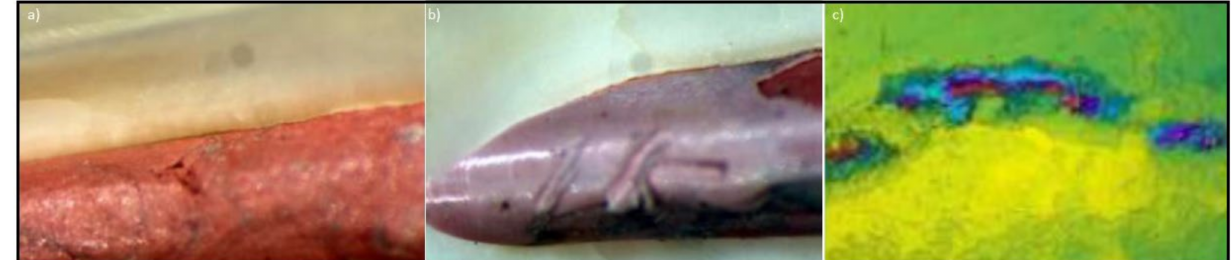
Figure 26. Leaks on the border of the dentine of the root canal and resilon covered with a thin intermediate layer of sealant after obturation using the thermoplastic condensation method with the THC technique (( a , b )—LSM, ( c )—LCM): ( a ) in the near-crown section; ( b ) in the apical segment; ( c ) observed in the laser confocal microscope LCM.